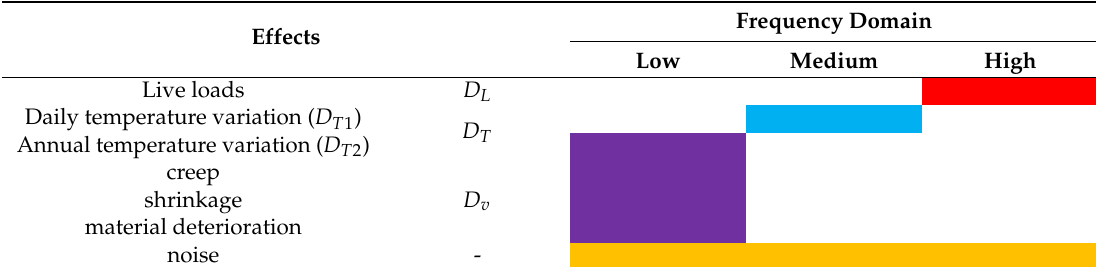
Table 1. Frequency domain of different effects.